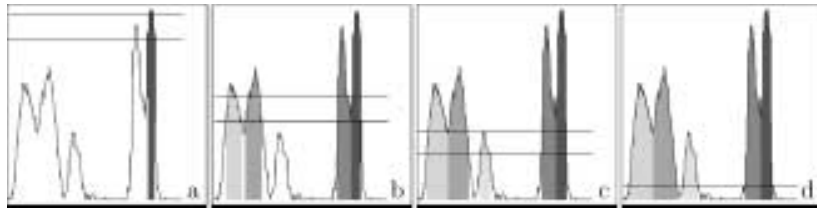
Fig. 5. Steps in the initial segmentation process. The two horizontal lines represent the upper and the lower threshold. New objects are found every time an unlabeled object reaches above the upper threshold. All pixels connected to a labeled object reaching above the lower threshold are given the same label. All the objects in the image are labeled as the thresholds slide down to the object-background